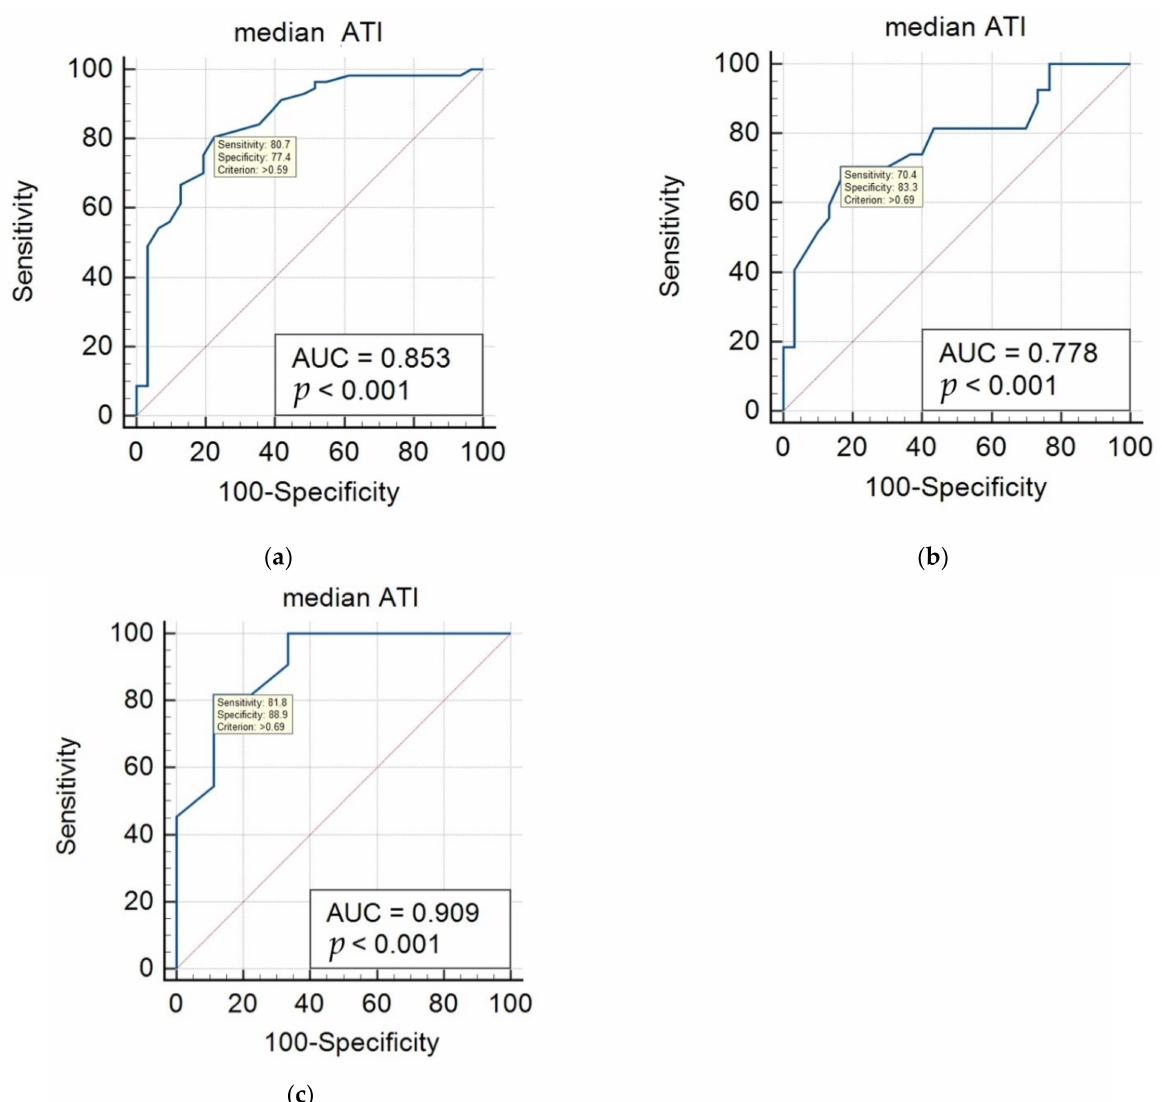
Figure 4. ROC curves of median ATI values for staging hepatic steatosis according to the grayscale US and MRI-PDFF. ( a ) For differentiating fatty liver (mild, moderate, severe) from the normal group according to the US criteria, a cutoff value of 0.59 dB/cm/MHz showed an AUC value of 0.853 (95% CI 0.762–0.920). ( b ) For differentiating moderate to severe fatty liver from mild fatty liver according to the US criteria, a cutoff value of 0.69 dB/cm/MHz showed an AUC value of 0.778 (95% CI 0.649–0.878). ( c ) For differentiating moderate to severe fatty liver from mild fatty liver according to MRI-PDFF, a cutoff value of 0.69 dB/cm/MHz showed an AUC value of 0.909 (95% CI 0.695–0.990). US: ultrasonography; ATI: attenuation imaging; MRI: magnetic resonance imaging; PDFF: proton density fat fraction; AUC: area under the curve; CI: confidence